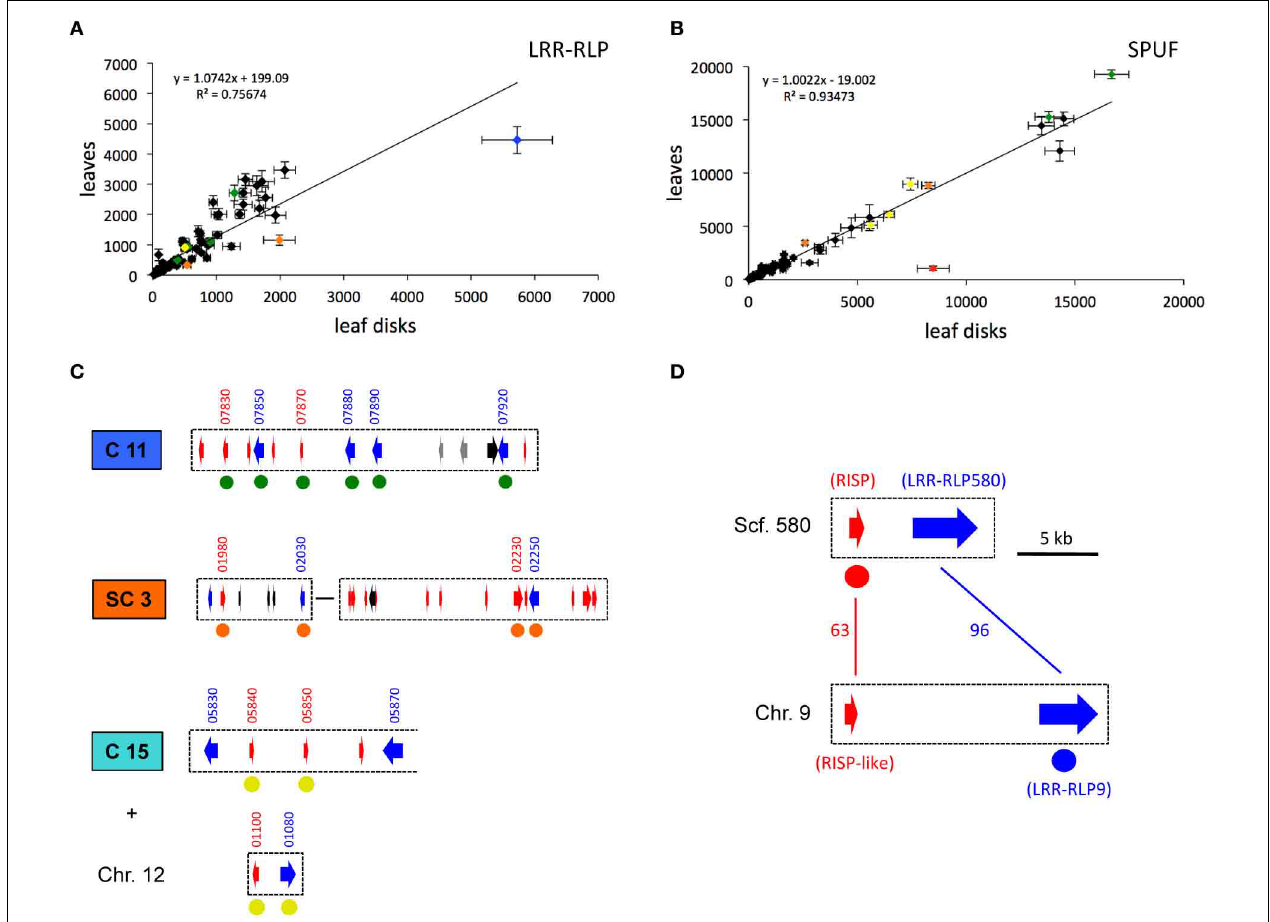
FIGURE 5 | The gene expression of some pairs of LRR-RLP/SPUF genes is coordinated. (A,B) The average levels of gene expression measured in poplar leaves (non-wounded condition) and in excised leaf disks (wounded condition) with oligoarrays are compared for the considered LRR-RLP (A) and SPUF (B) genes. Error bar: SE, n = 6. The linear regression and associated values are indicated for each graph. Colored points are further discussed in the text and in the parts (C,D) . The complete transcriptome dataset is available in Table S1C. (C) Cluster 11 (C11), a sub-part of Super-Cluster 5 (SC5), and Cluster 15 (C15) associated with a pair of LRR-RLP/SPUF genes from chromosome 12 (Chr.12) are